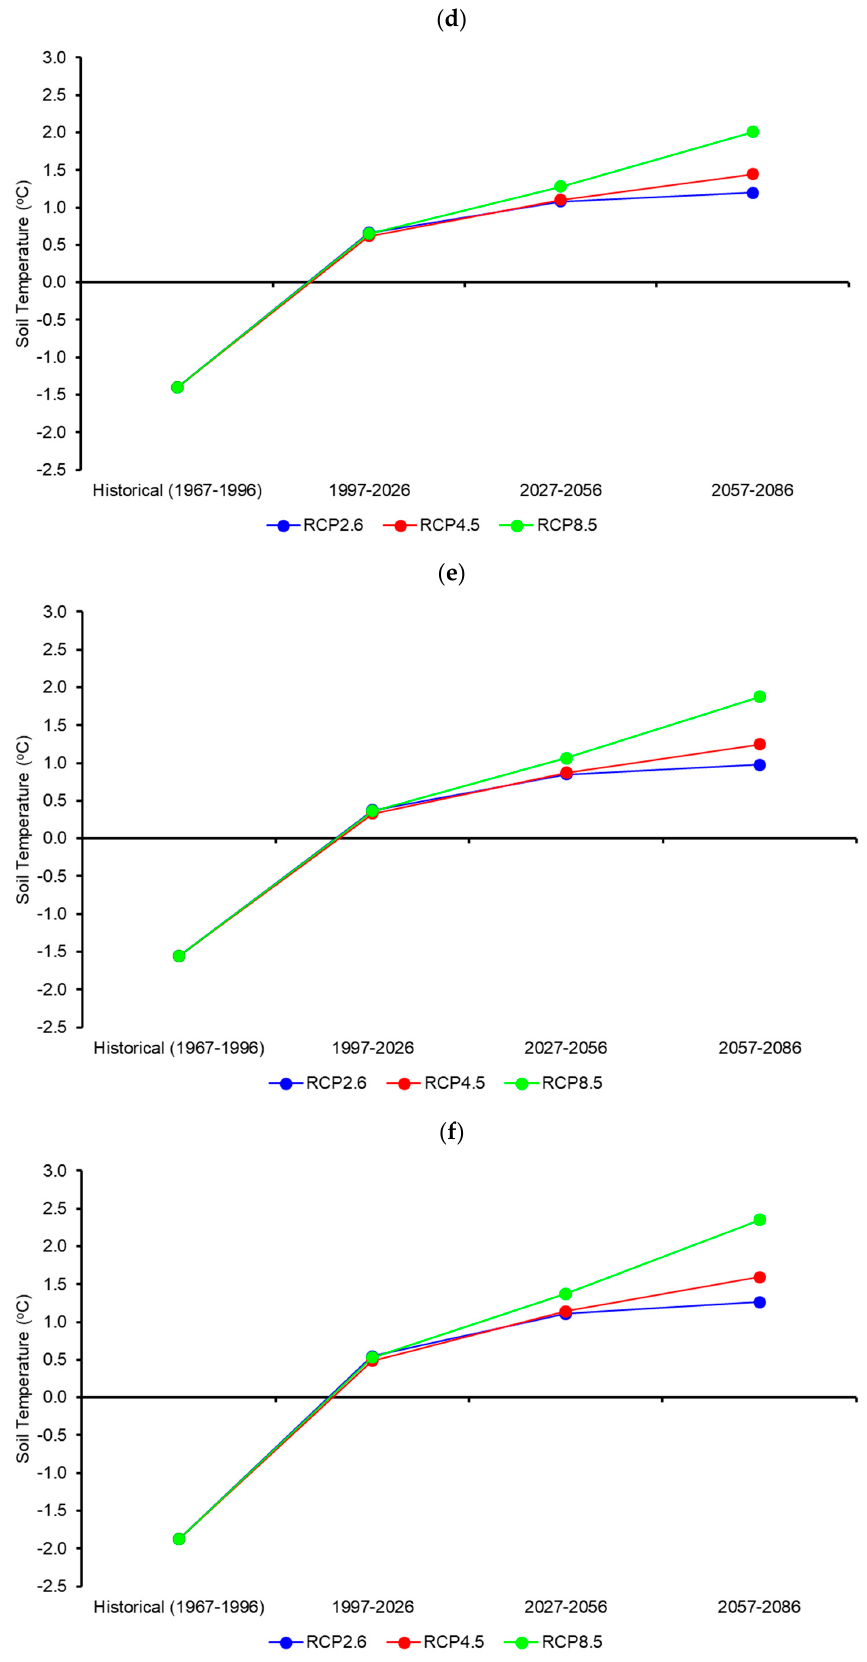
Figure 9. Annual soil temperature projections from 1997 to 2086 for depths at: ( a ) 5 cm; ( b ) 10